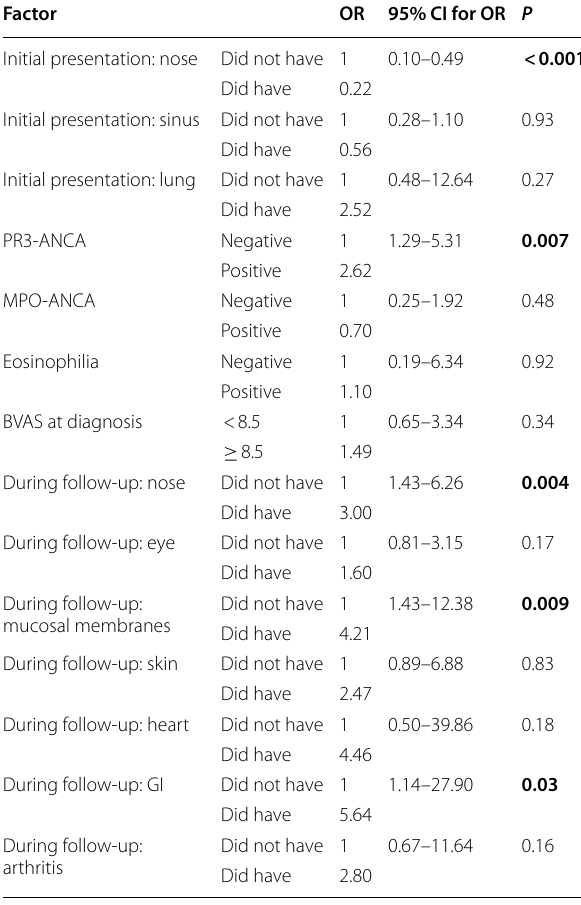
Table 2 Logistic regression analysis for predicting relapse of